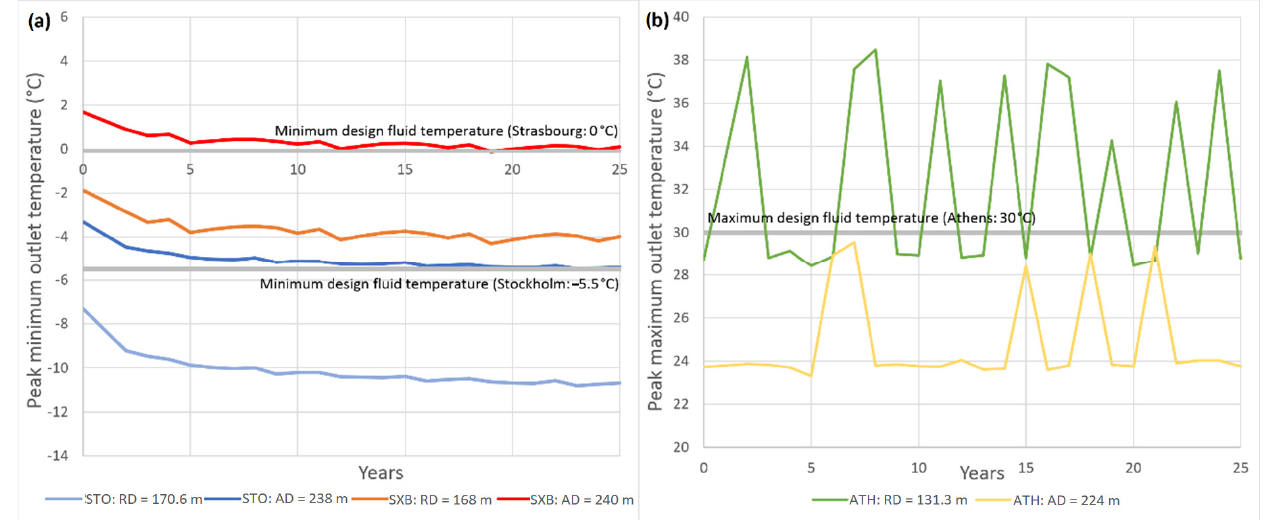
Figure 8. Peak outlet temperatures for preliminary and alternative design during 25 years in: ( a ) Stockholm and Strasbourg and ( b ) in Athens.